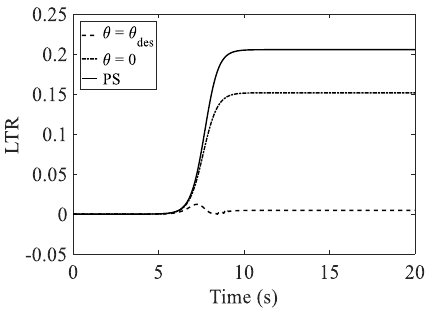
Figure 8. Lateral load transfer ratio.